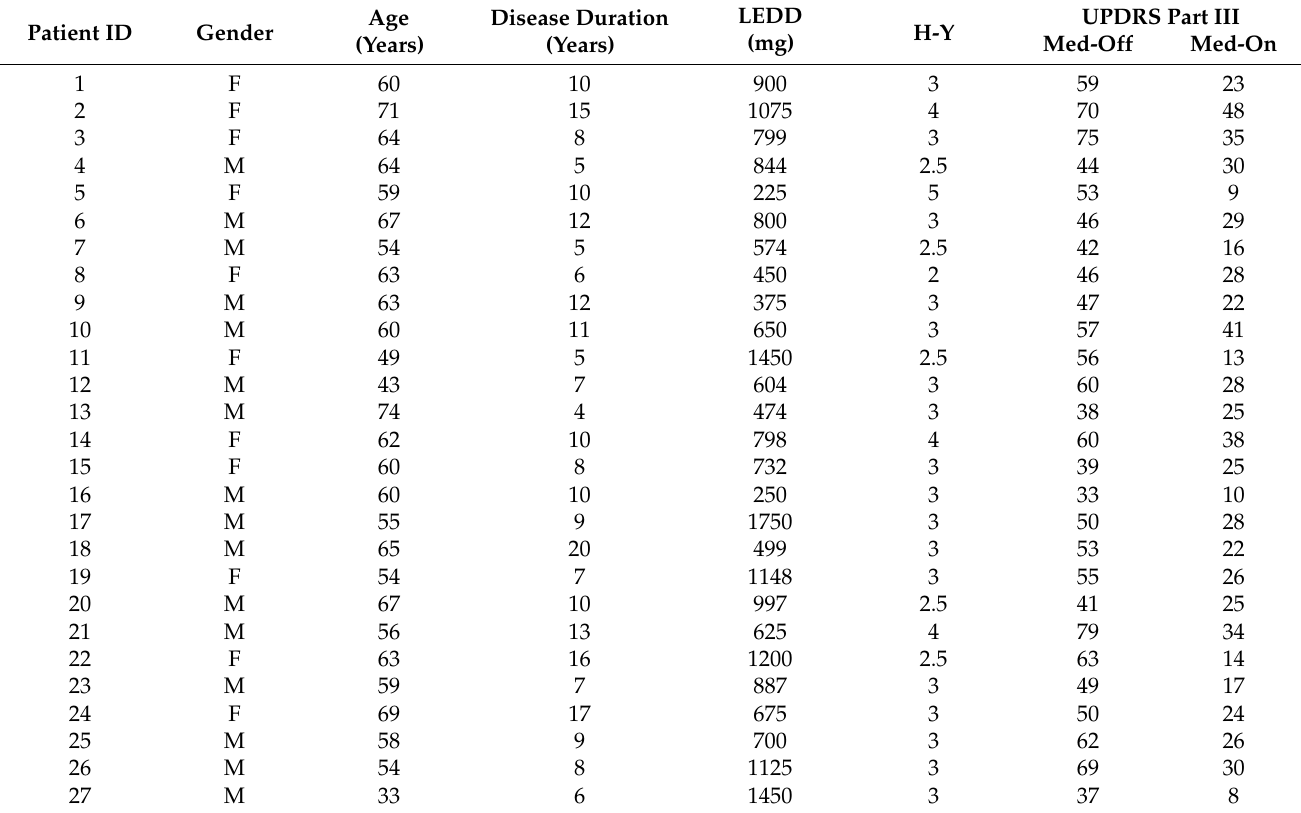
Table 1. Demographic and clinical characterizations for the PD